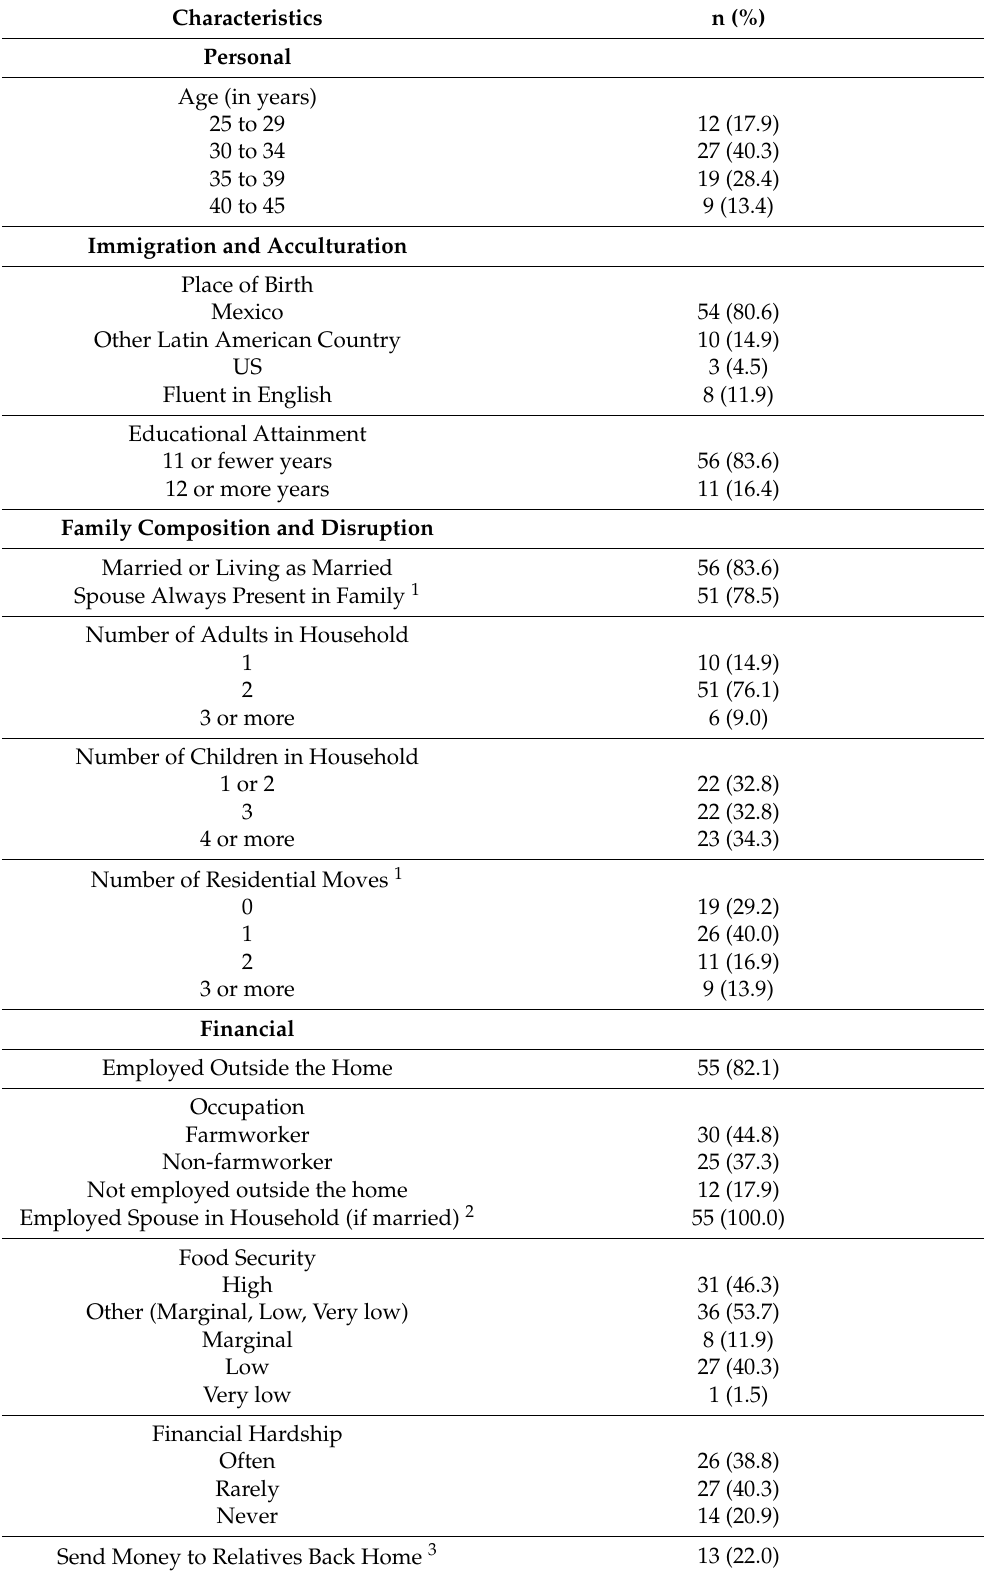
Table 1. Personal, Immigration and Acculturation, Family Structure and Disruption, and Financial Characteristics for Latinx Women in Farmworker Families, North Carolina, 2018–2019 (N =